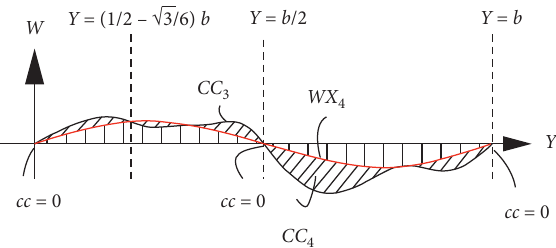
Figure 8: The fourth interpolation function on the plane ( Y, Z )